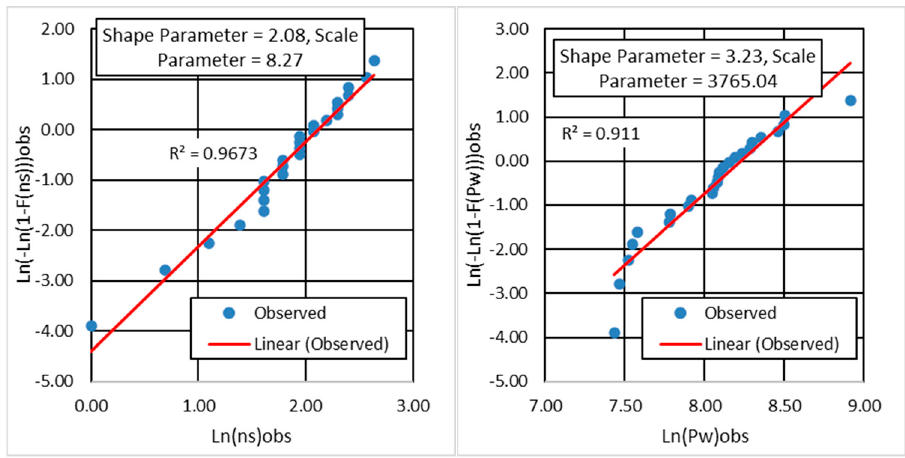
Figure 7. Weibull descriptors of arriving ships ( left ) and installed engine power ( right ).